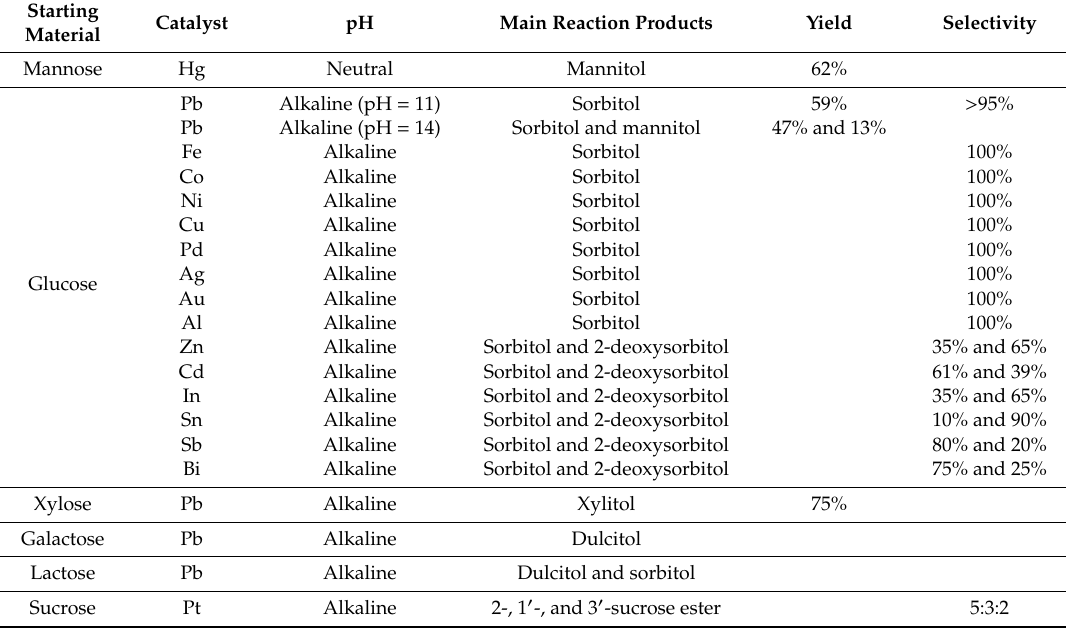
Table 11. Summary of the saccharide electro-reduction